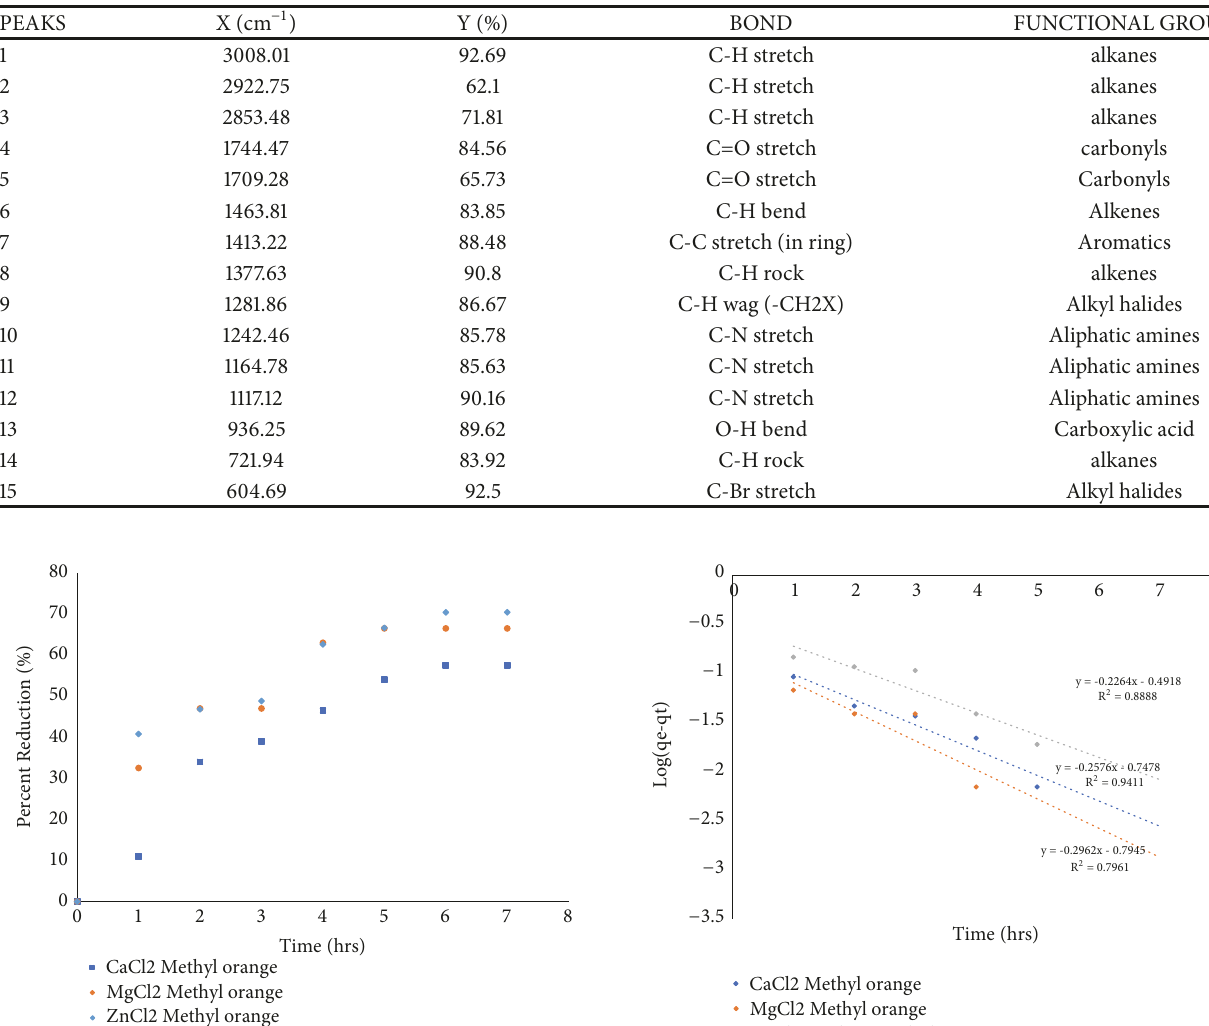
Table 2: Table of the FTIR results of the Oil showing the various frequencies, % transmittance and their functional assignments. PEAKS